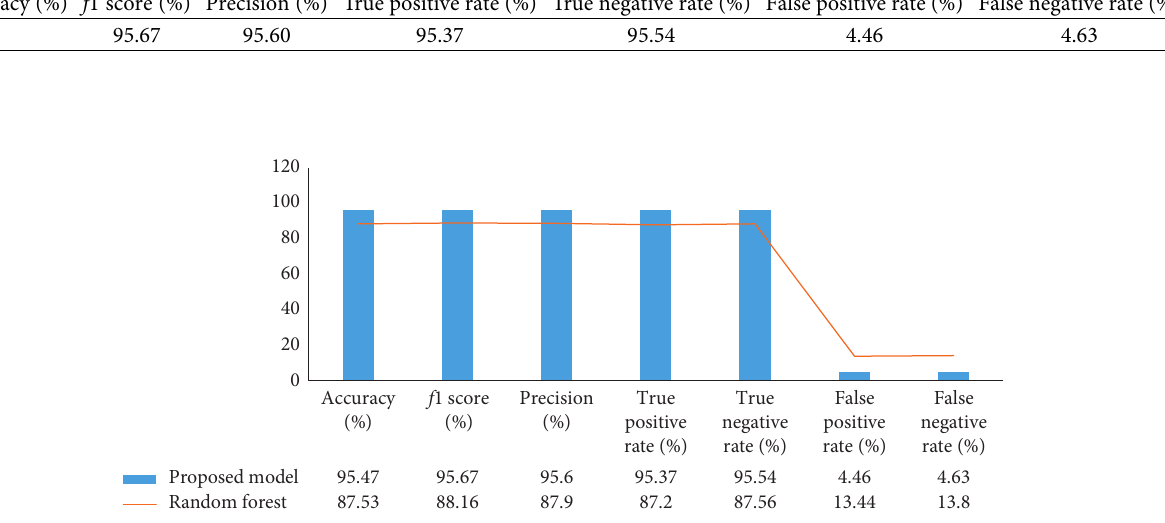
Figure 8: Performance comparison of the proposed model with the RF.